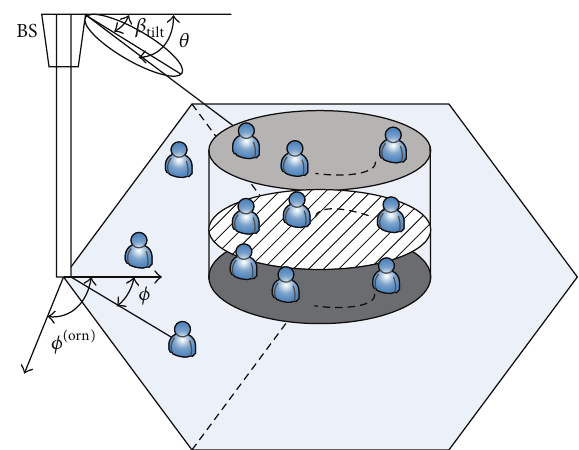
Figure 2: Schematic illustration of 3D MIMO in single